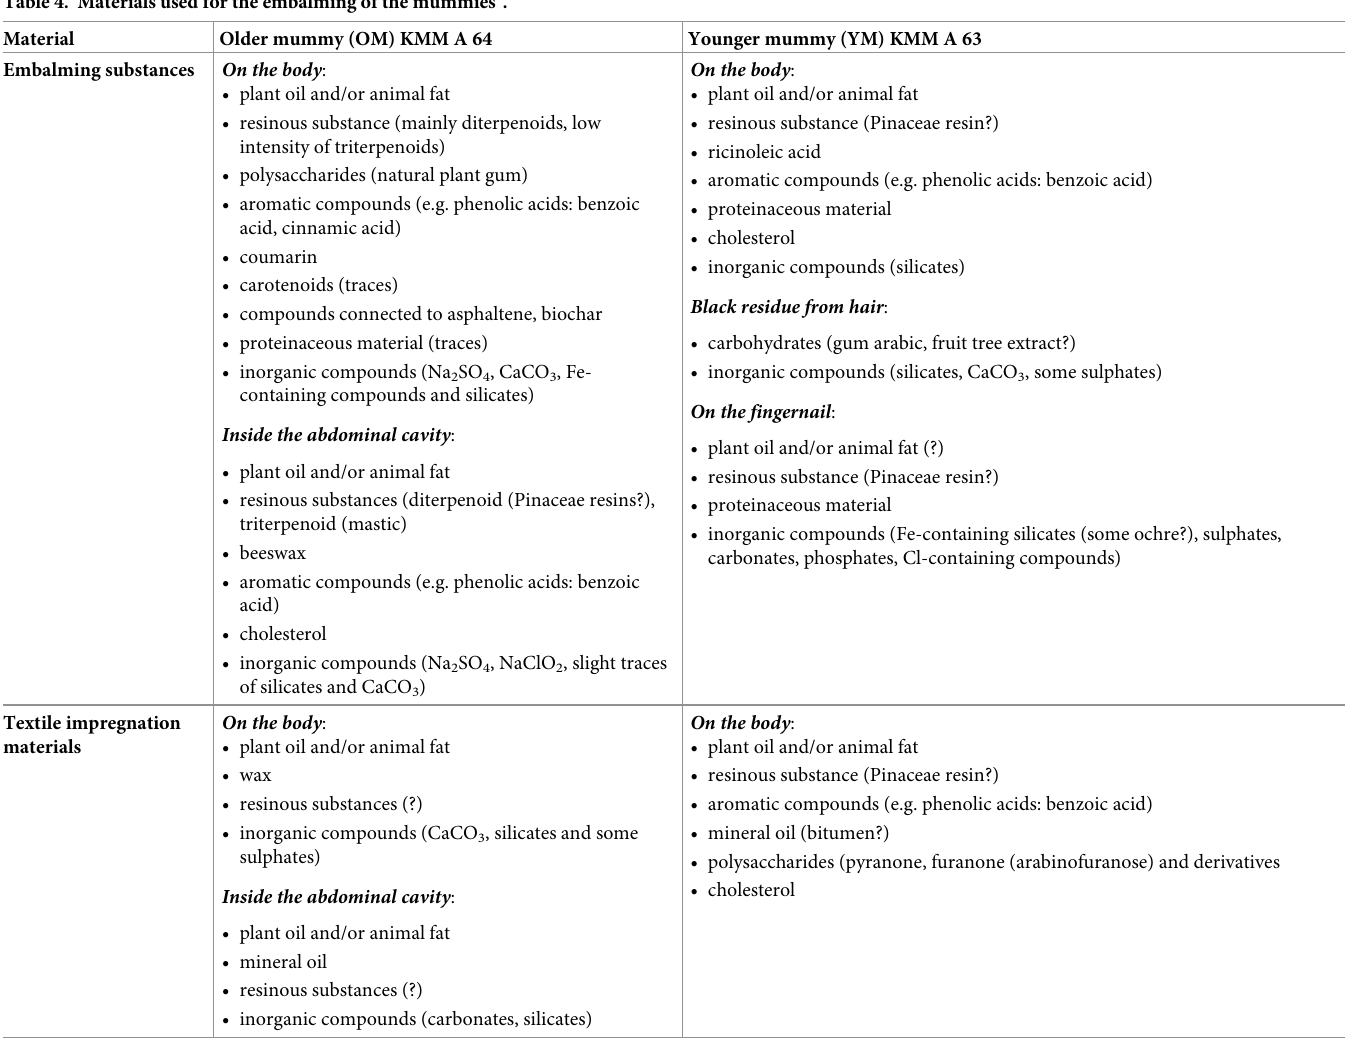
Table 4. Materials used for the embalming of the mummies a .